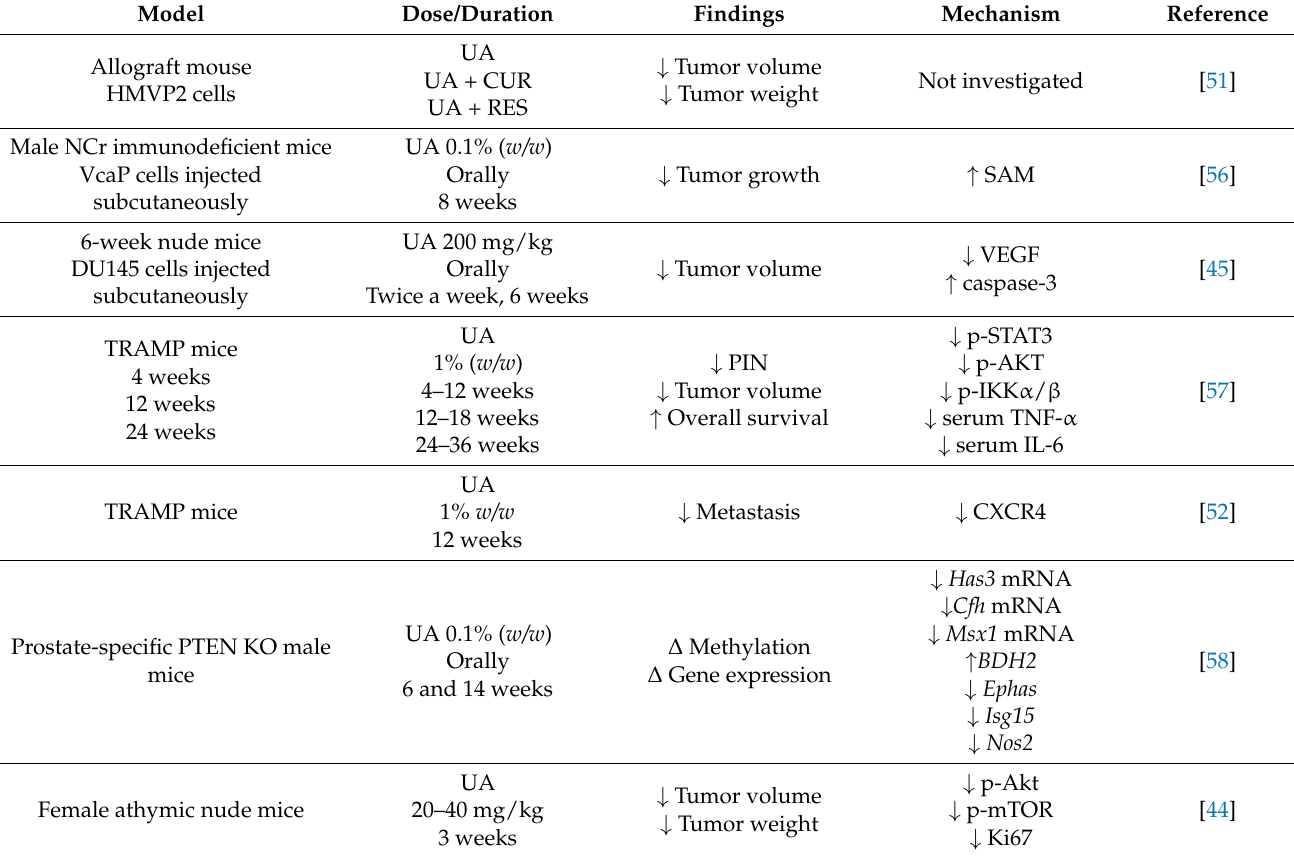
Table 2. Effects of ursolic acid against prostate cancer: summary of in vivo studies.